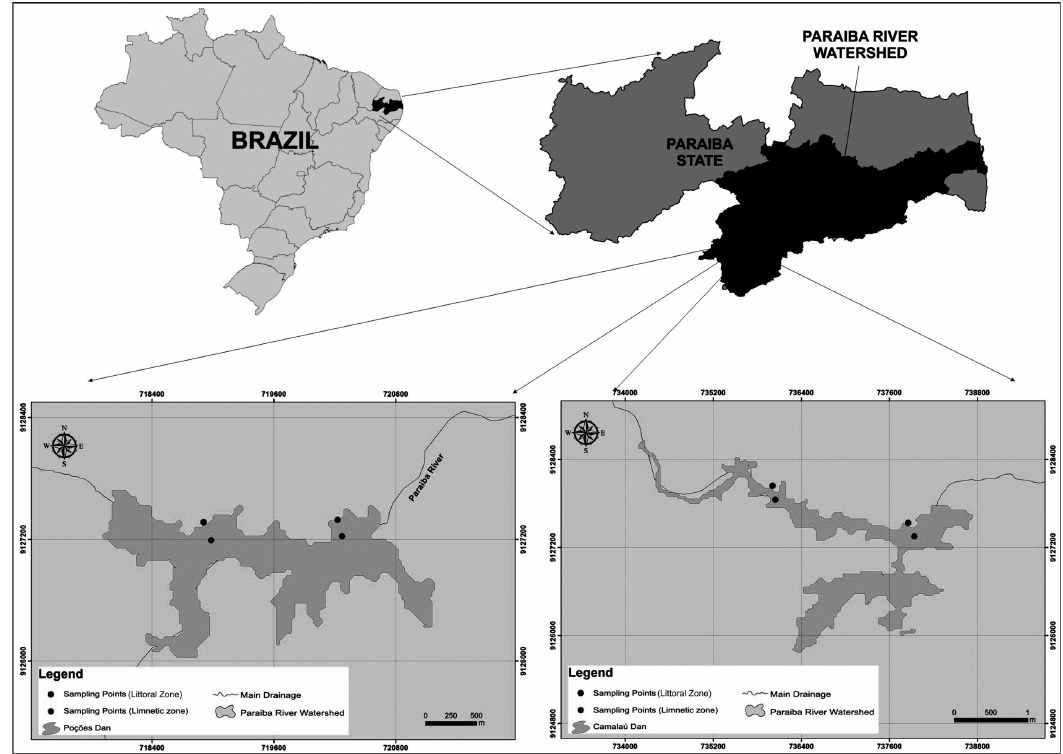
Figure 1. Location of Poções and Camalaú reservoirs, Paraíba River basin, State of Paraíba,